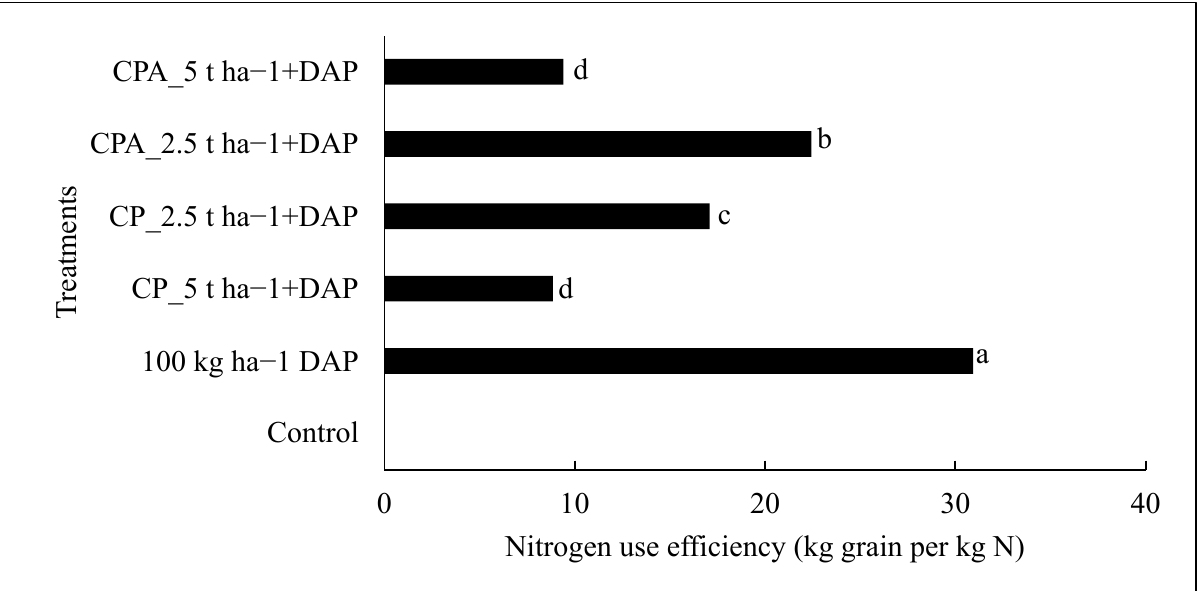
Figure 3. Nitrogen use efficiency (sorghum grain per kilogram of nitrogen used (kg per kg N).